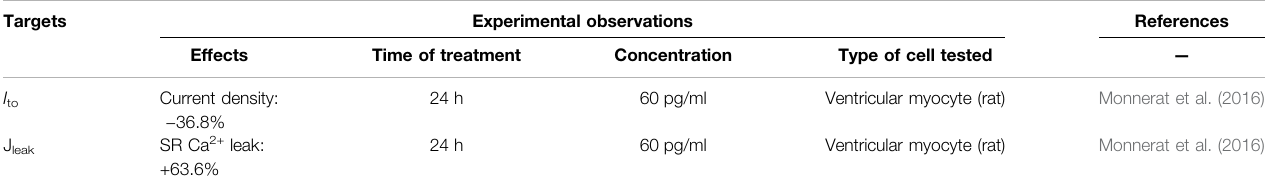
TABLE 3 | The effects of IL-1 β on cellular targets.